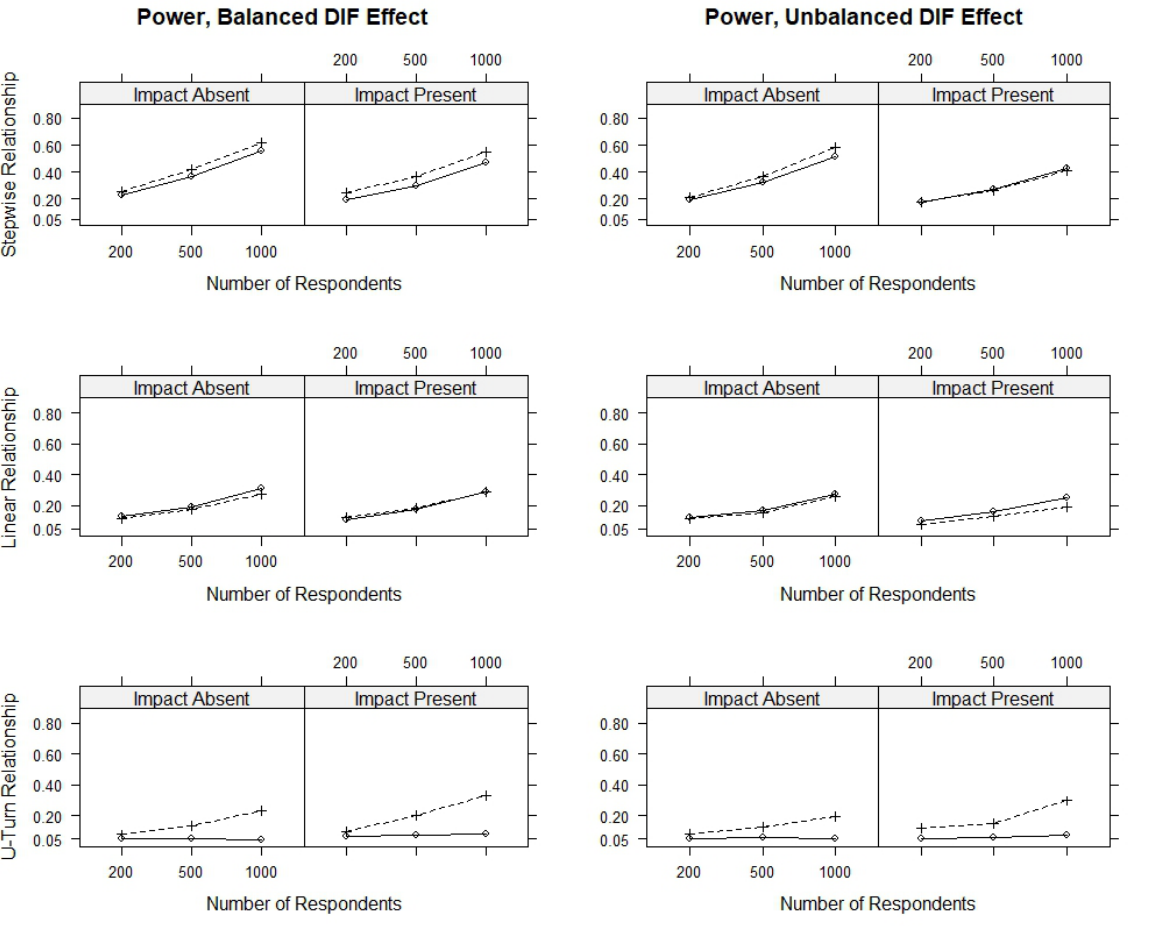
Figure 3. Power of two tests against balanced and unbalanced DIF in the β parameter for modules of 9 items and one DIF item per module. The person parameter was estimated by applying the WL estimator to all observed responses. The unbroken line presents the results for the linear logistic regression test, the broken line presents the results for the score-based bootstrap